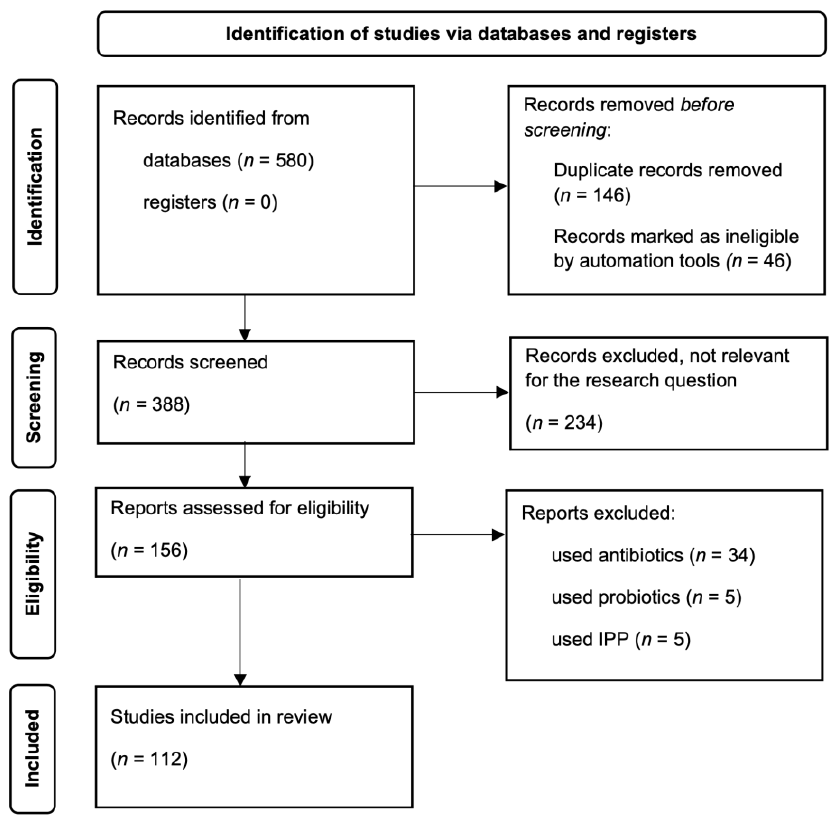
Figure 1. Search strategy and results. Table 1. Original studies investigating the co-existence of SIBO with different disorders.